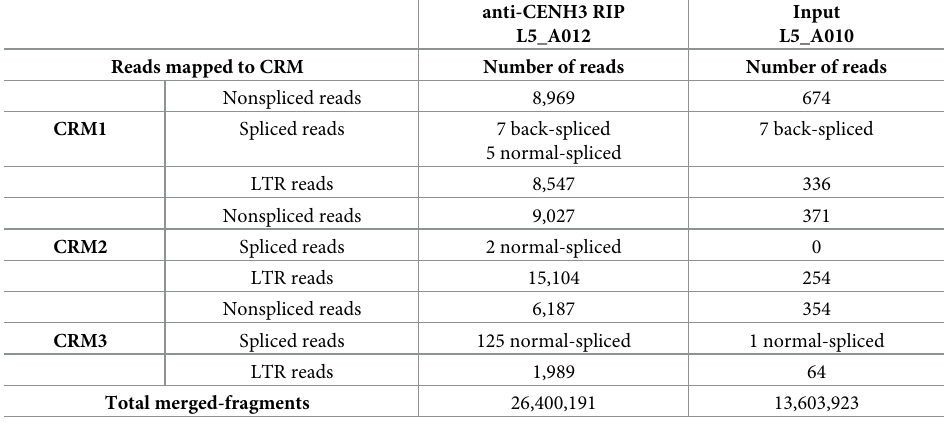
Table 1. The number of merged fragments from anti-CENH3 RIP mapped to the CRM